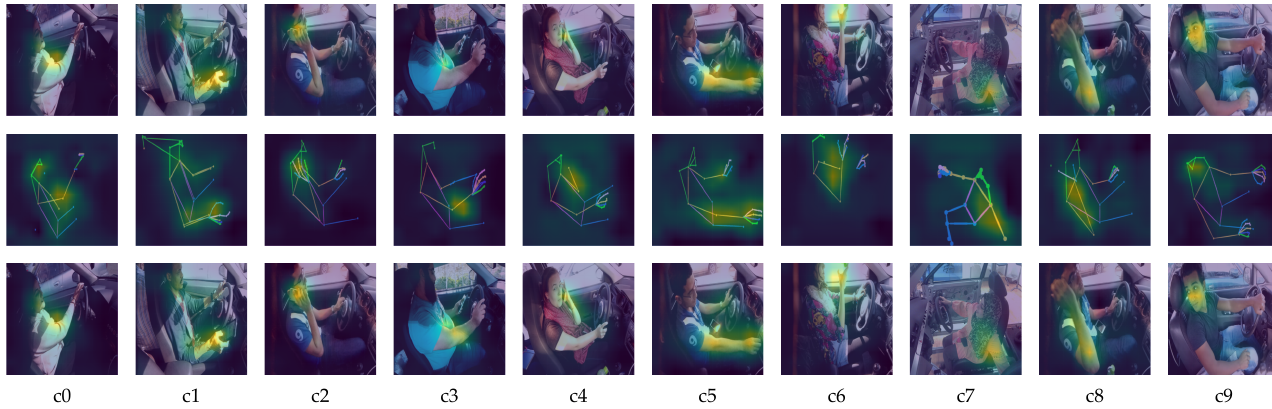
Figure 8. Heatmap of the feature area. First row represents the heatmap generated by ResNet101 on original images. Second row represents the heatmap generated by ResNet50 on pose estimation images. Third row represents the heatmap generated by our proposed